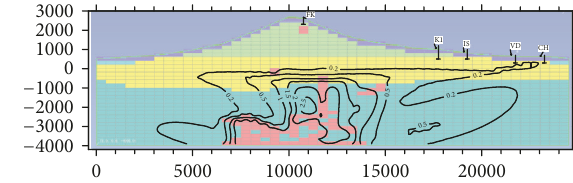
Figure 9: Distributions of modeled pressures (bar) (TOUGH2- EOS1) (6A). Horizontal and vertical axes are labeled in meters.